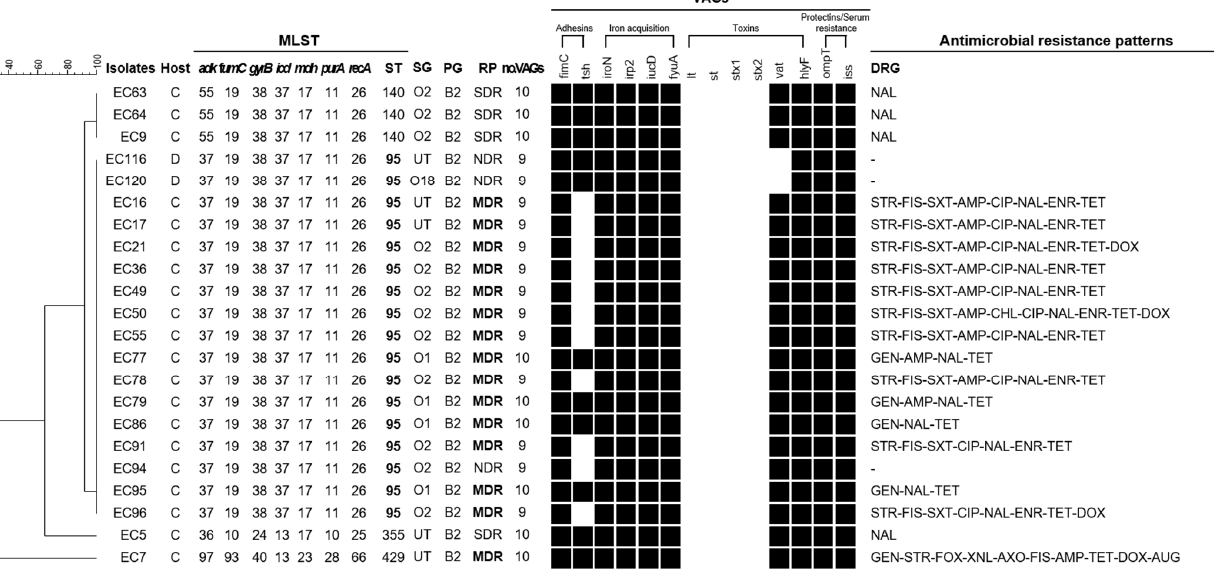
Figure 2. Characteristics and dendrogram based on Multi-locus sequence typing (MLST) among the 22 APEC isolates belonging to group B2. Phylogenetic tree based on the 7 concatenated gene sequences. Black squares: positive reaction; white squares: negative reaction; ST: sequence type; SG: serogroup; PG: phylogenetic group; RP: resistant phenotype; no.VAGs: number of virulence-associated genes; C: chicken; D: duck; NDR: non-drug resistant; SDR: non-multidrug resistant; MDR: multidrug resistant; AMP: ampicillin; AUG: amoxicillin/clavulanic acid; AXO: ceftriaxone; CHL: chloramphenicol; CIP: ciprofloxacin; DOX: doxycycline; ENR: enrofloxacin; FIS: sulfisoxazole; FOX: fefoxitin; GEN: gentamicin; NAL: nalidixic acid; STR: streptomycin; SXT: trimethoprim/sulfamethoxazole; TET: tetracycline; XNL: ceftiofur.